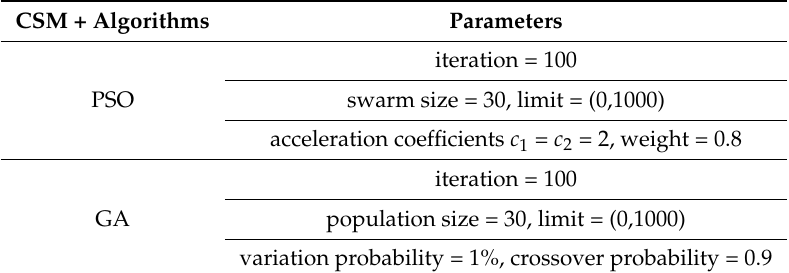
Table 1. Particle swarm optimization (PSO) and genetic algorithm (GA) algorithm